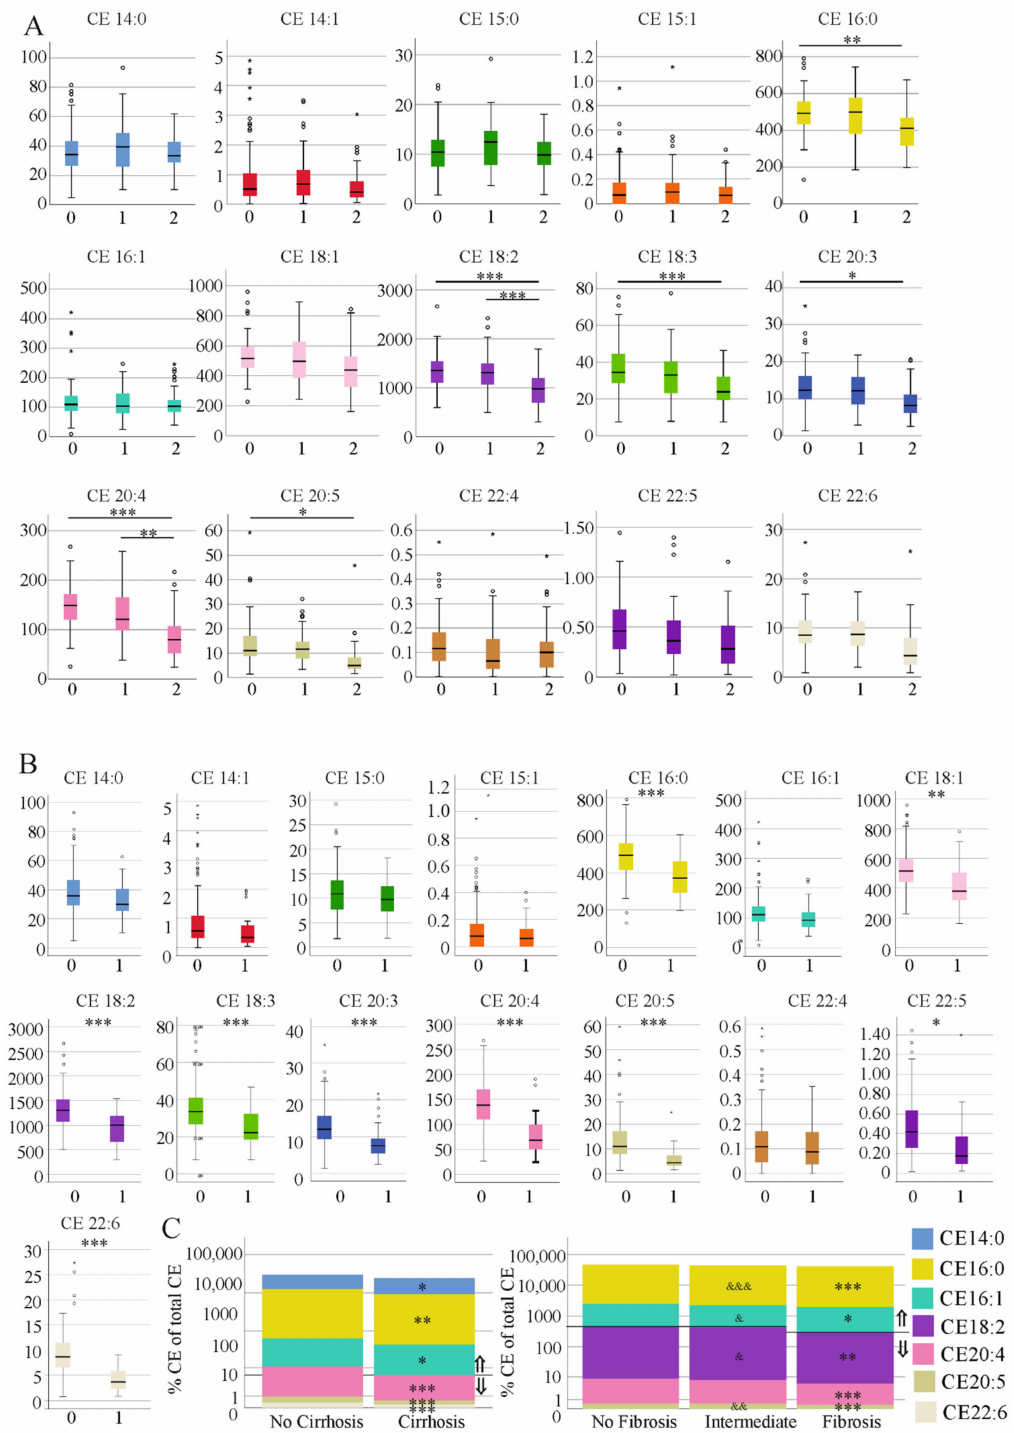
Figure 2. Cholesteryl ester (CE) species and CE profile in relation to the FIB-4 score and to cirrhosis diagnosed by ultrasound. ( A ) CE species in patients with no fibrosis (0), in patients with an inter- mediate FIB-4 score (1) and patients with fibrosis (2). ( B ) CE species in patients without and with liver cirrhosis diagnosed by ultrasound. Small circles or asterisks above or below the boxes mark outlier. ( C ) % CE of total CE levels of the patients described in ( A , B ) ⇑ higher in fibrosis/cirrhosis ⇓ lower in fibrosis/cirrhosis (& p < 0.05, && p < 0.01; &&& p < 0.001 for comparison of patients with an intermediate and a high FIB-4 score. * p < 0.05, ** p < 0.01, *** p <